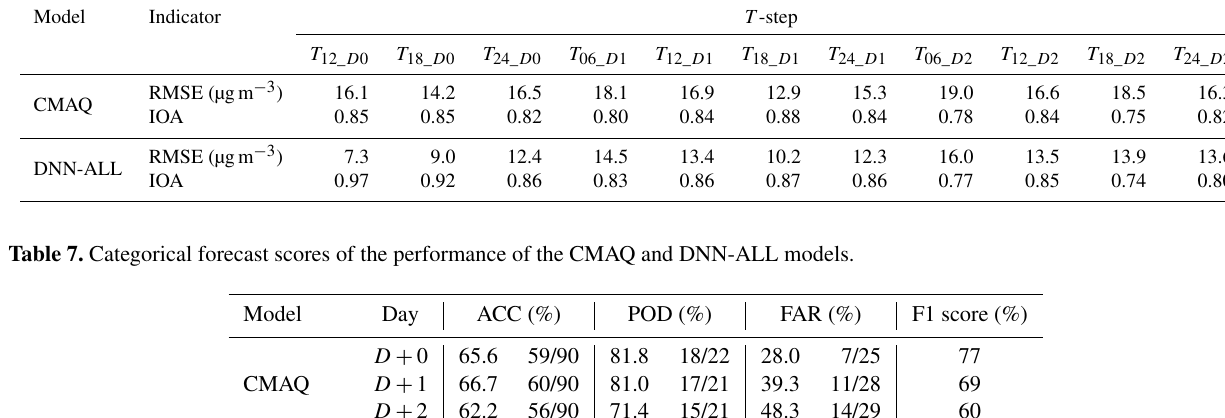
Table 6. Statistical summary of the performances of the CMAQ and DNN-ALL models in the case of 6h average PM 2 . 5 forecasts. Model Indicator